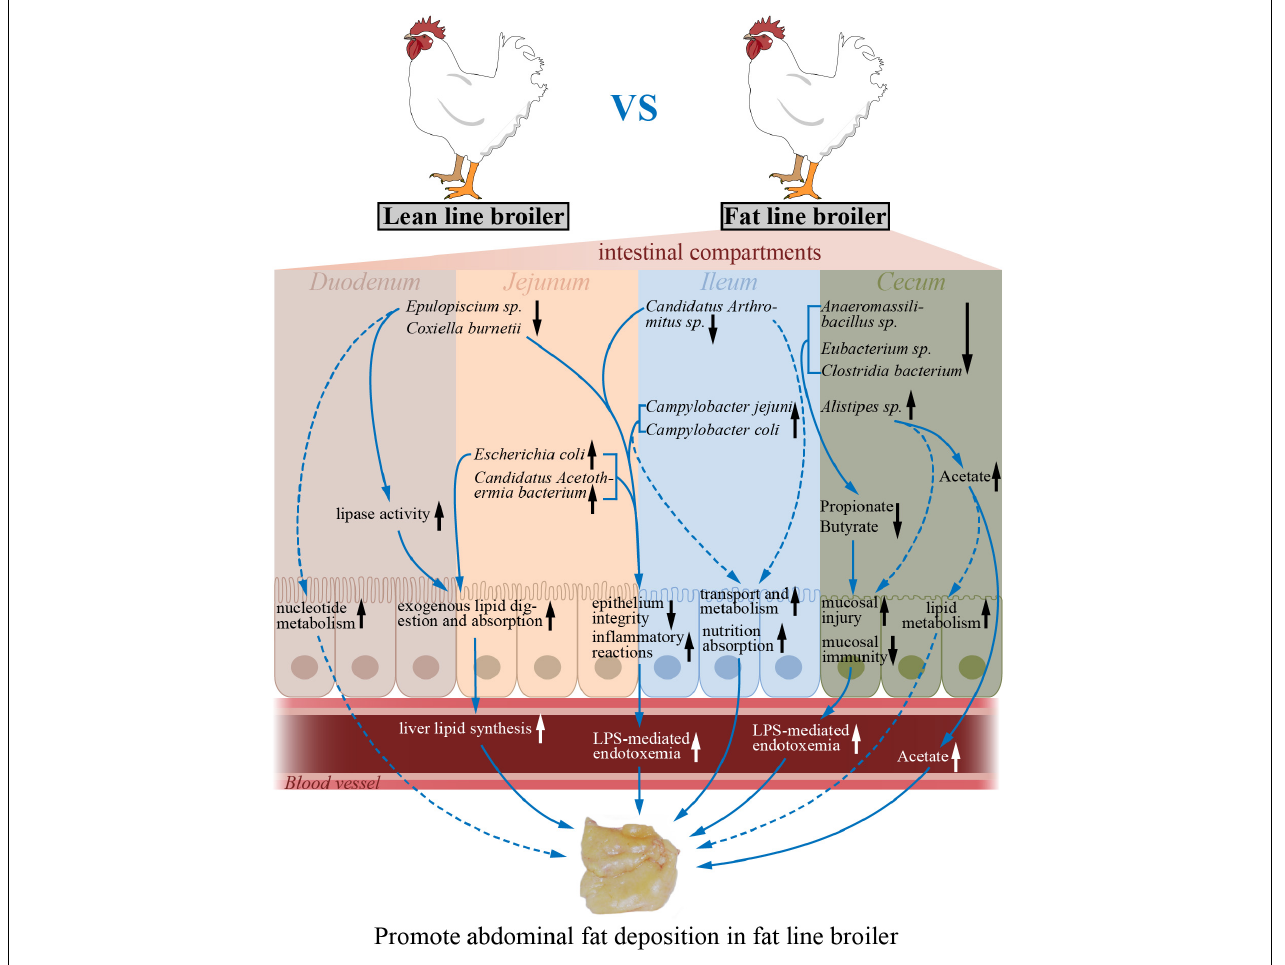
FIGURE 6 | The potential model of how varied microbes impacted by host genetic selection regulate intestinal functions to promote abdominal fat deposition. The up and down arrows (black) indicate increased and decreased intestinal functions or microbial abundances in the fat-line broilers compared to the lean-line broilers. The dotted arrows (blue) designate those changes that are predicted by intestinal transcriptome–microbiome interactions. The solid arrows (blue) represent the regulatory effects of the microbes and